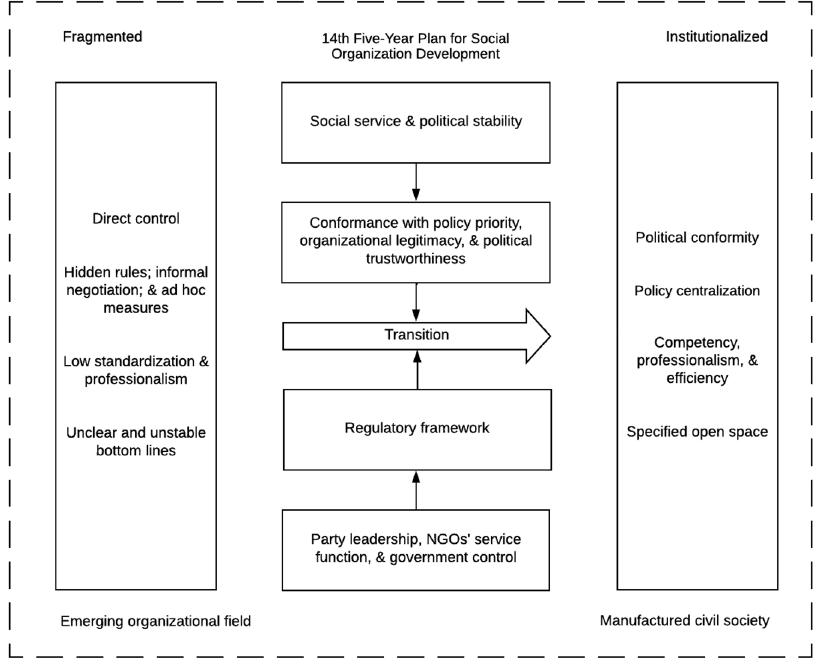
Figure 1: The plan in the transition process of China ’ s nonprofit